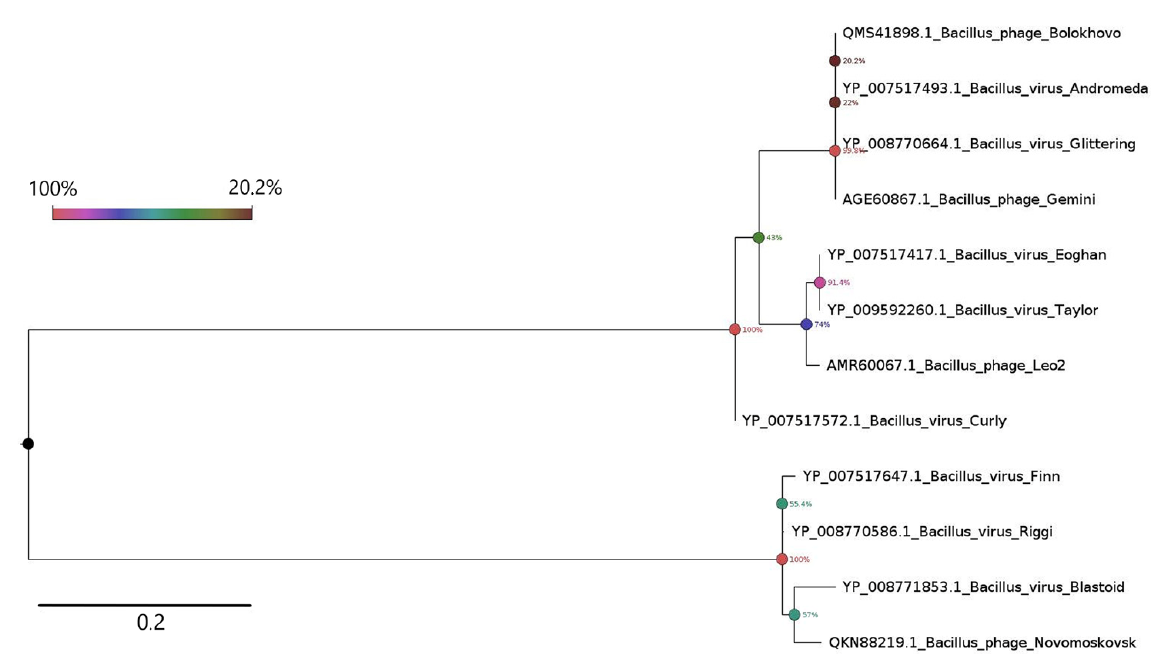
Figure 8. Phylogenetic analysis of the depolymerases of Novomoskovsk, Bolokhovo and the members of Andromedavirus . The phylograms were constructed using the Maximum Likelihood method [53] with 500 bootstrap replicates. The scale bars represent the number of amino acid substitutions per site.